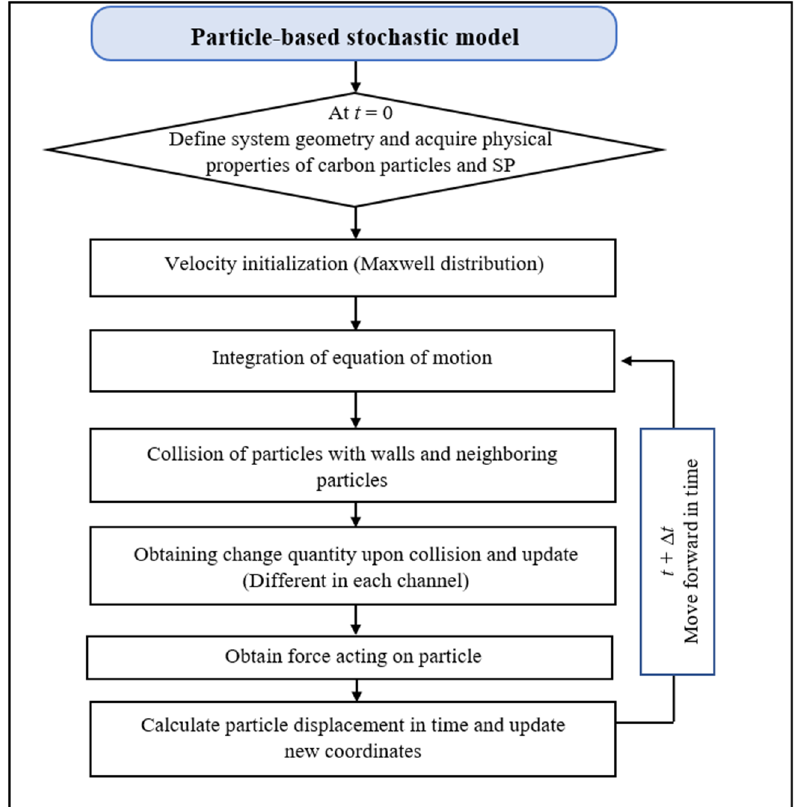
Figure 6. Loop diagram of the numerical solution process.